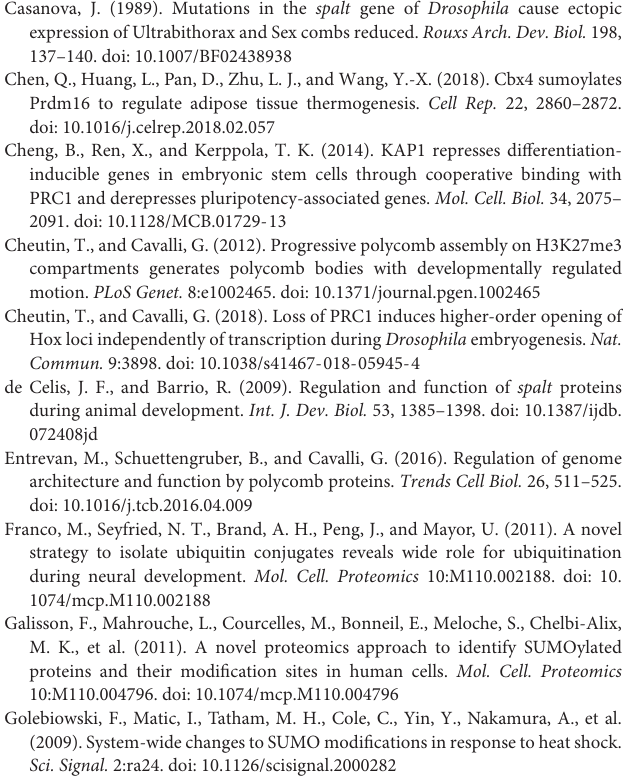
Supplementary Figure 4 | CBX4 and SALL1 localize to the nucleoplasm. Endogenous CBX4 (A) and endogenous SALL1 (B) shown in green localize to nuclear bodies in U2OS cells (A (cid:48) ,B (cid:48) ) . Increasing the intensity reveals the localization of both proteins in the nucleoplasm (A (cid:48)(cid:48) ,B (cid:48)(cid:48) ) . Single green channels are shown in black and white. Pictures were taken using a Leica DM IRE2 confocal microscope with a 63 × objective. Supplementary Figure 5 | SALL1 SUMOylation is independent of CBX4. In vitro SUMOylation of SALL1 with SUMO1 or SUMO2/3 in the presence of growing quantities of CBX4 (in µ l). Wheat germ was added as negative control. The vertical bar indicates the SUMOylated forms of SALL1, the empty arrowhead indicates the unmodified SALL1. Molecular weight markers are shown to the right in KDa. Supplementary Figure 6 | Variation of Polycomb bodies upon SALL1 expression. Representative composition of independent U2OS cells transfected with equal amounts of SALL1-YFP, SALL1 (cid:49) SUMO-YFP, or GFP- β -gal plasmids, stained for endogenous CBX4. Nuclei were labeled with DAPI (not